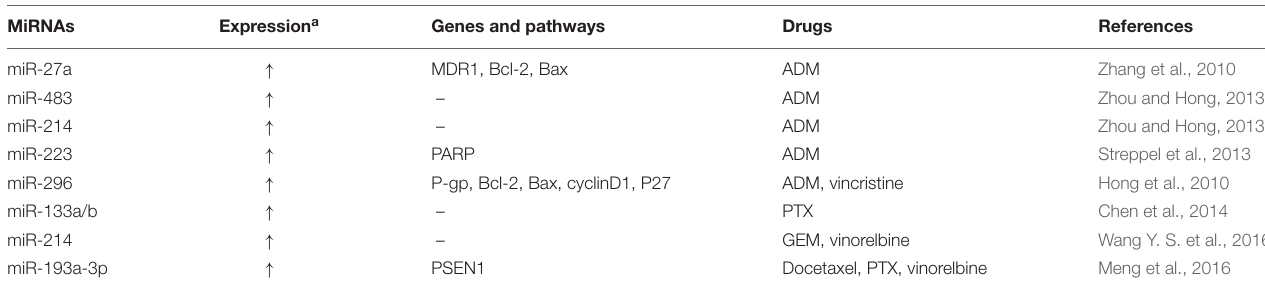
TABLE 3 | MicroRNAs (miRNAs) and resistance to other drugs in esophageal cancer. MiRNAs Expression a Genes and pathways Drugs